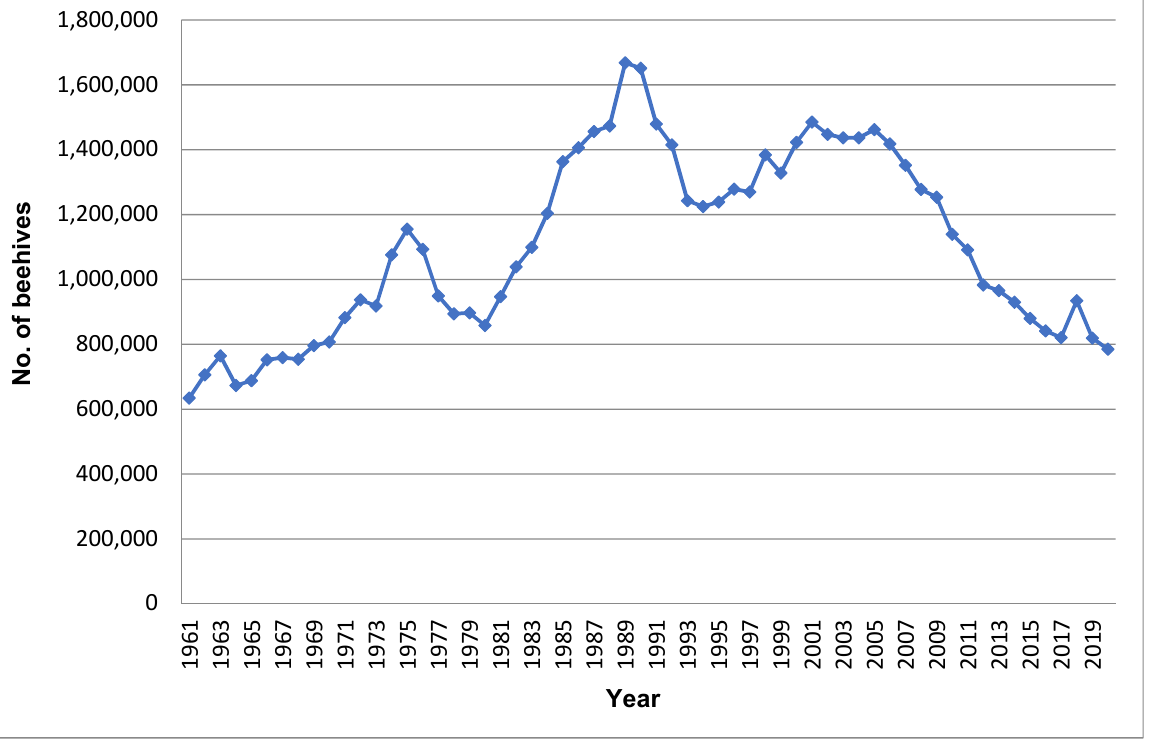
Figure 4. Beehives stocks in Egypt within the period (1961–2020) according to FAO (Data